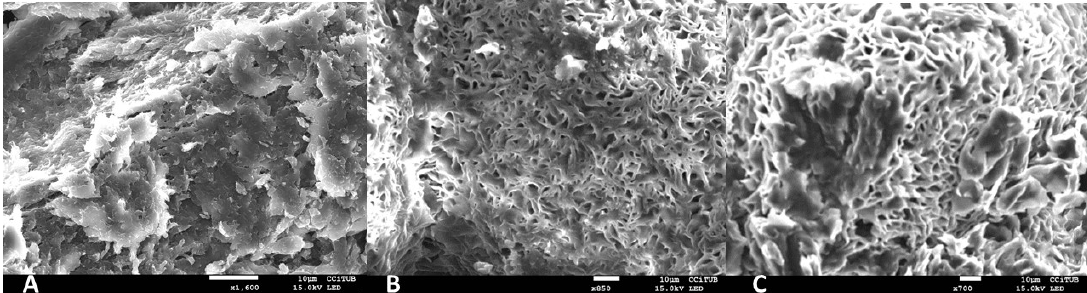
Figure 3. Scanning electron microscopy (SEM) images of ( A ) DPZ-CGel magnification 850×, ( B ) DPZ-PGel 1 and ( C ) DPZ-PGel 2 magnification 450×. Scale bar equals 10 µm.